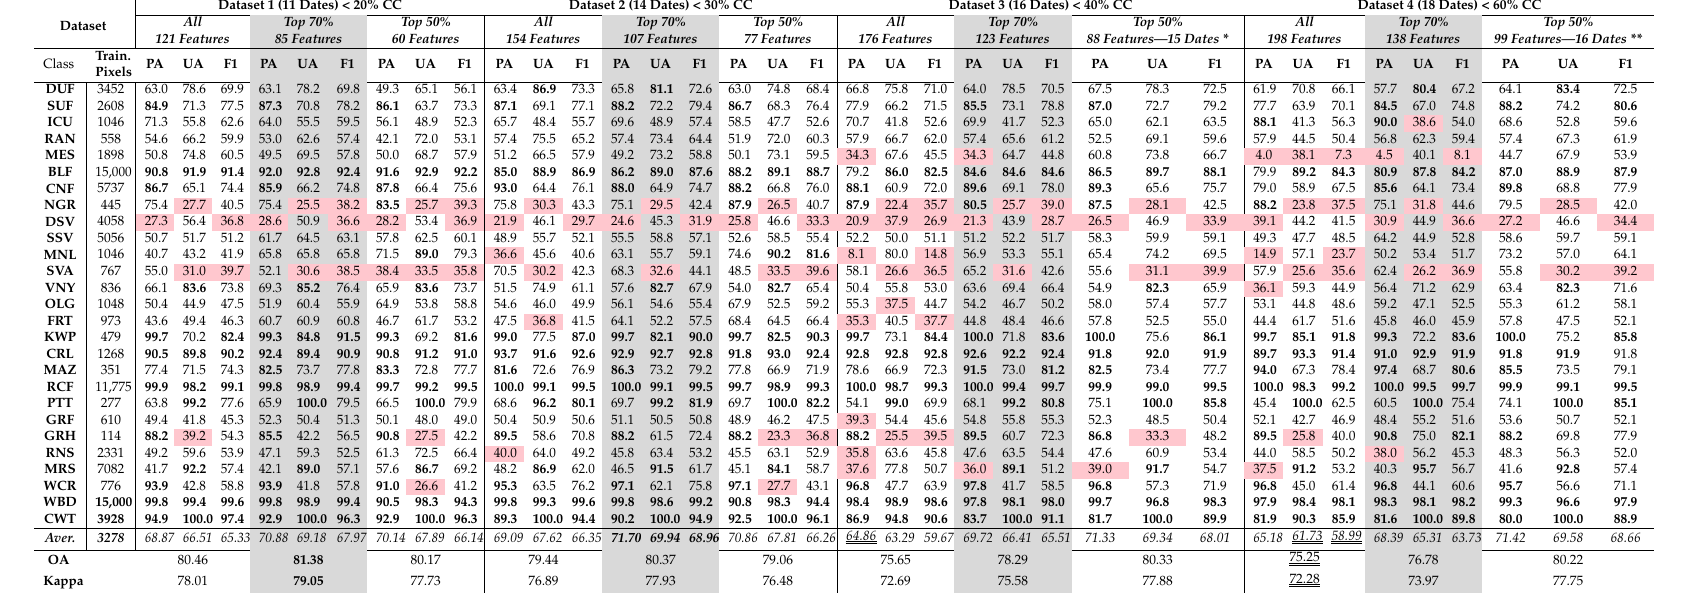
* All features of date 9 February 2016 were excluded on Dataset #3 Top 50% selection. ** All features for dates 7 November 2016 and 25 December 2016 were excluded on Dataset #4 Top 50% selection